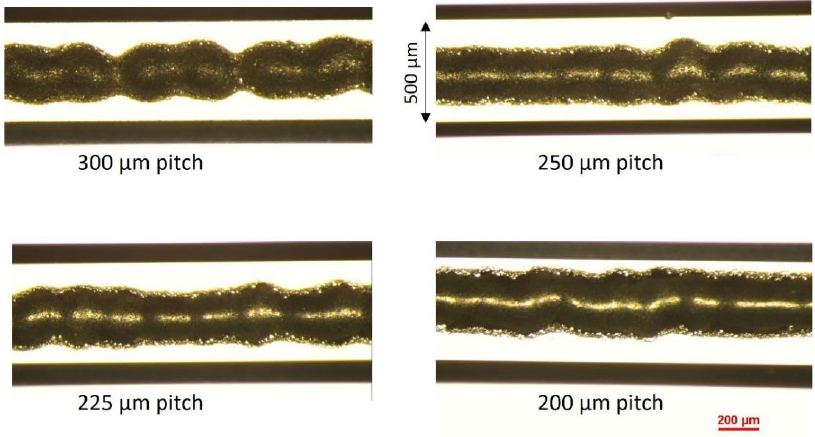
Figure 7. The effects of jetting pitch on the topography of the printed bond